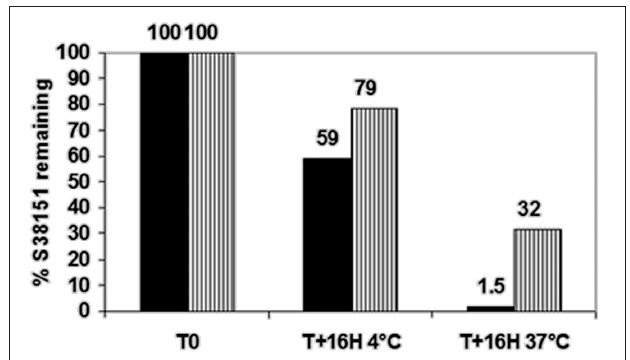
FIGURE 2 | Studies regarding the stability of S38151. A solution of S38151 (40 μ M) was incubated with either Tris buffer, pH 7.4 (hatched bars), or mouse plasma samples (dark bars) for 16h at 4 ◦ C or 37 ◦ C. The samples were analyzed using liquid chromatography coupled to mass spectrometry. Experiments were repeated three times. The chart presented is representative of the experimental results.